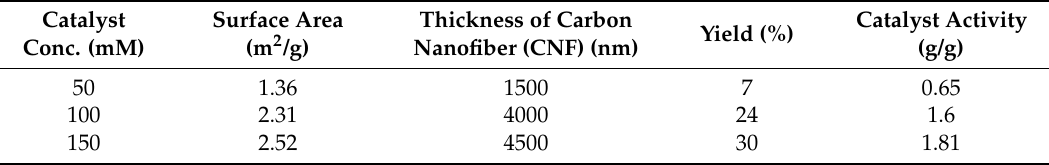
Table 1. Surface area, thickness, and yield of carbon fiber-carbon nanofiber (CF-CNF) and activities of the different catalyst concentration at 550 ˝ C for 30 min under 50 sccm acetylene flow